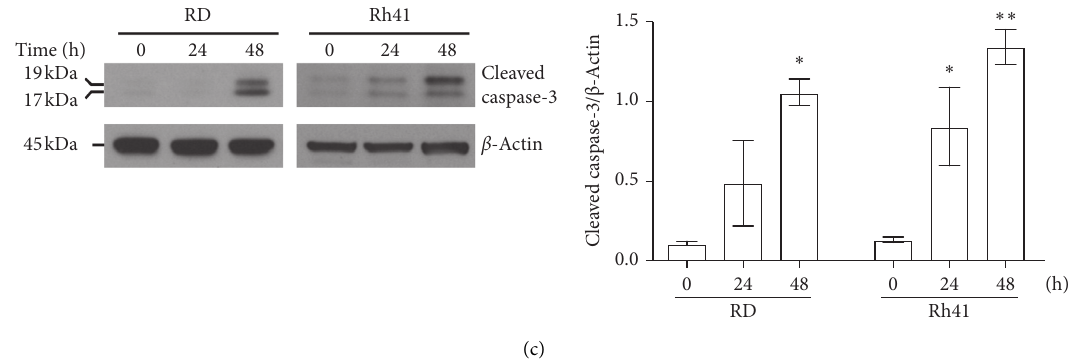
Figure 2: NSC668394 treatment triggers caspase-induced apoptosis in RMS cells. (a) Representative flow cytometry dot plots of RMS cell lines stained with annexin V and 7-AAD following treatment with 10 μ M NSC668394 or DMSO for 96h. (b) Percentage of cells determined to be annexin V+ or annexin V+/7AAD+ were quantified after 0, 48, and 96h after treatment with DMSO or NSC668394. Individual bars are represented as mean ± SEM and representative of three independent experiments. Asterisks represent a significant difference between vehicle and treated groups ( ∗ p < 0 . 05, ∗∗ p < 0 . 005, ∗∗∗ p < 0 . 0005, and p < 0 . 0001 � ∗∗∗∗ ) for the given time point, as determined by two-way ANOVA with Dunnett’s multiple comparisons test. (c) Representative Western blot of cleaved caspase-3 levels in RD or Rh41cells treated with 10 μ M NSC668394 for indicated times. Relative band intensity was determined using ImageJ software and depicted in the bar graph. Blots are representative of three independent experiments.